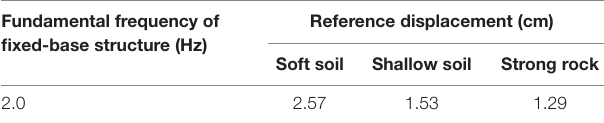
TaBle 4 | summary of the reference